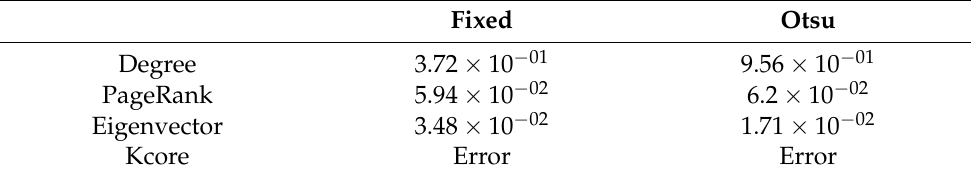
Table 3. p -values from the MANOVA test of the average and Otsu’s thresholds on window 3.5–5.5